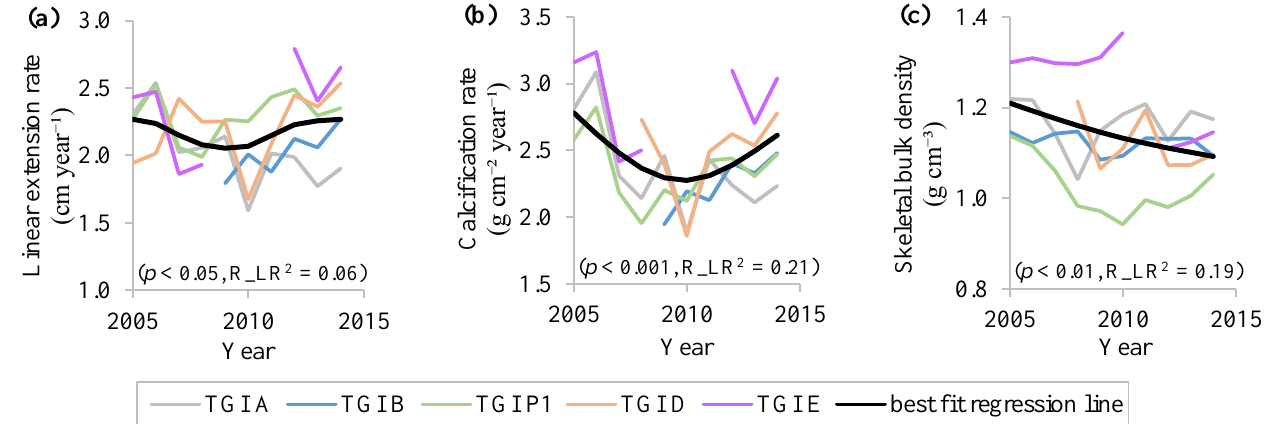
Figure 3. Plots show annual coral skeletal growth of ( a ) linear extension rate, ( b ) calcification rate, and ( c ) skeletal bulk density for five coral cores (colored lines) and the estimated trend with best fit regression (black lines) for the period December 2004 – November 2014. The significances of the regression line at p < 0.001/0.01/0.05 and R_LR 2 are shown in brackets. 95% confidence intervals of regression lines were not shown for clarity of plots.